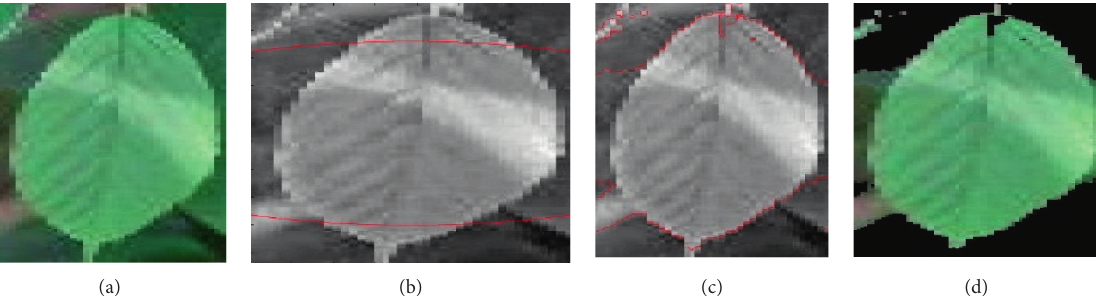
Figure 6: The result of Chan–Vese algorithm segmenting healthy leaf: (a) image capture; (b) initial zero level set; (c) contour image after 500 iterations; (d) segmentation results.